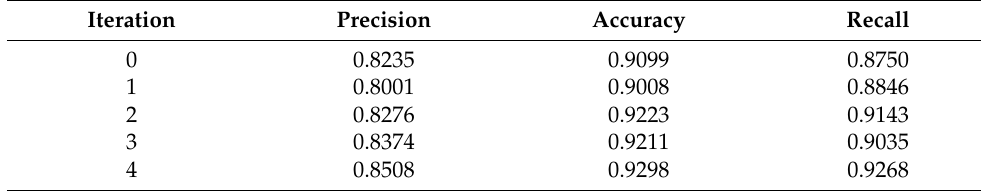
Figure 11. The apportion of all samples for training and validation. Table 3. Experimental results of the iteration.